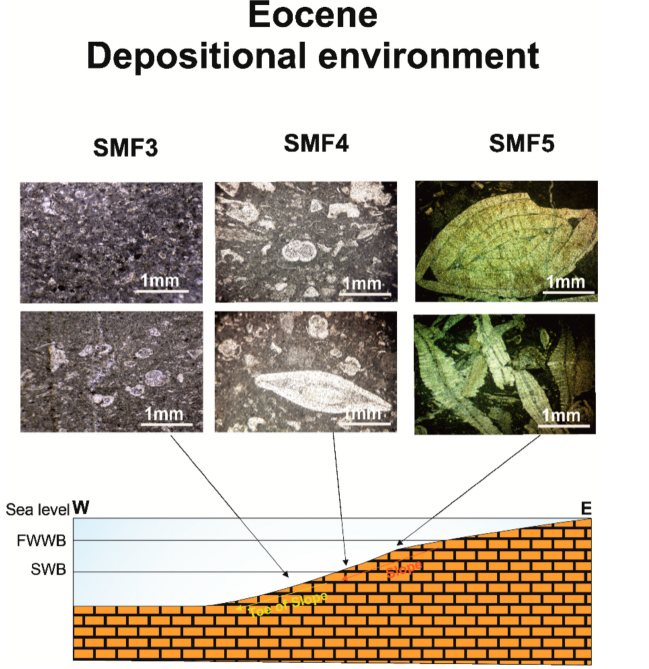
Figure 21. Microfacies types and the corresponding depositional environments/Facies Zones during the Eocene.